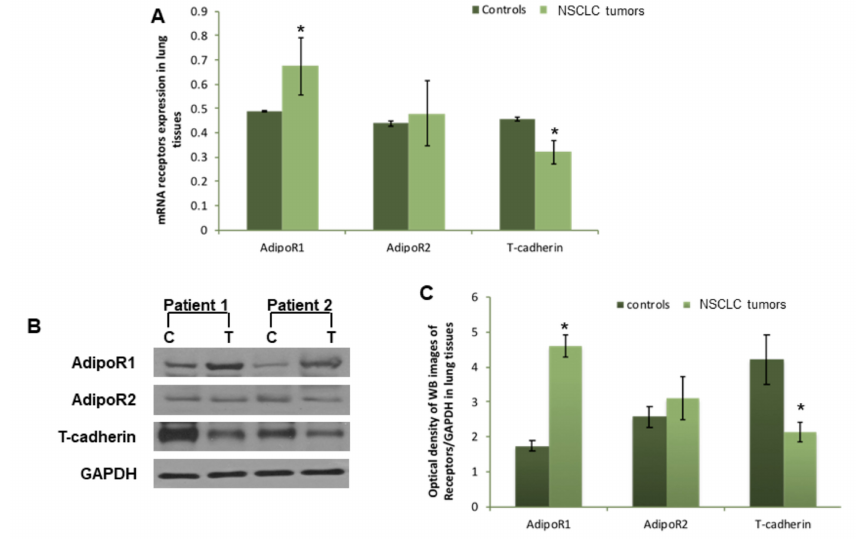
Figure 2. Di ff erent modulation of AdipoR1, AdipoR2, and T-cadherin expression in cancerous lung tissues compared to non-cancerous tissues. ( A ) Real-time PCR analysis of AdipoR1, AdipoR2, and T-cadherin relative to GAPDH expression in lung non-cancerous tissues and cancerous tissues (data expressed as the mean of 2 − ∆ Ct ). ( B ) One representative western blot image of AdipoR1, AdipoR2, T-cadherin, and GAPDH in lung non-cancerous tissues compared to cancerous tissues; ( C ) pixel quantization representation of AdipoR1, AdipoR2, and T-cadherin in 20 lung non-cancerous tissues and cancerous tissues. * p < 0.05 (Student t -test). For further details, see the materials and methods